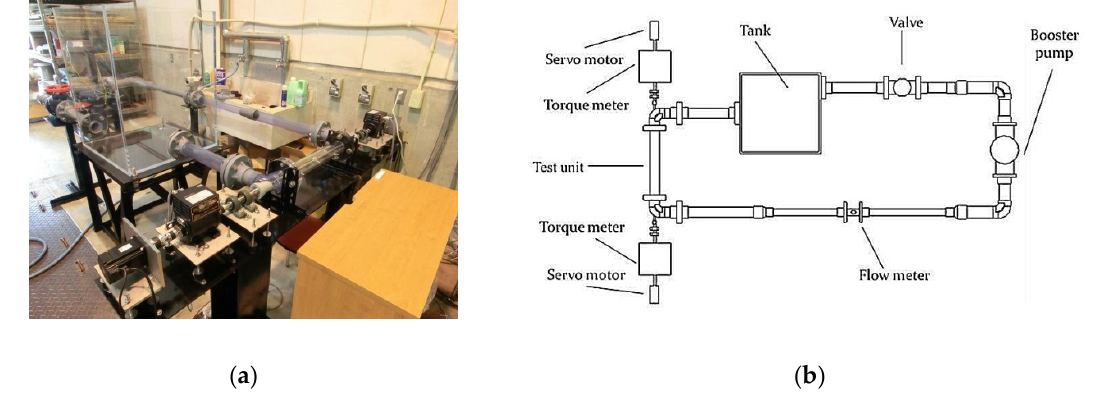
Figure 2. The experimental apparatus of contra-rotating small hydro-turbine: ( a ) Photo of experimental apparatus, the flow direction is clockwise; ( b ) Schematic diagram of the experimental apparatus.